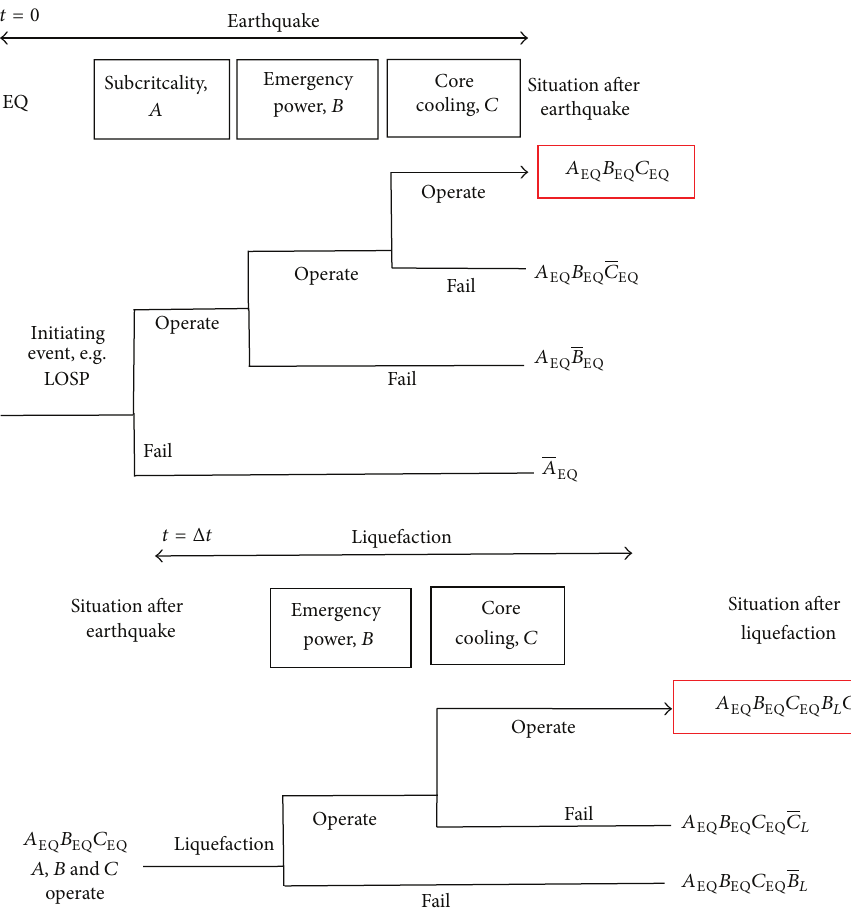
Figure 1: Simplified plant event-tree for earthquake and